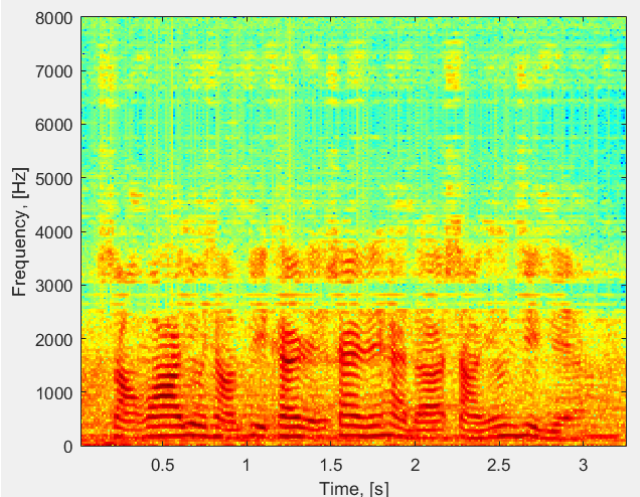
Figure 15. Spectrum of the mixed speech received by center microphone.